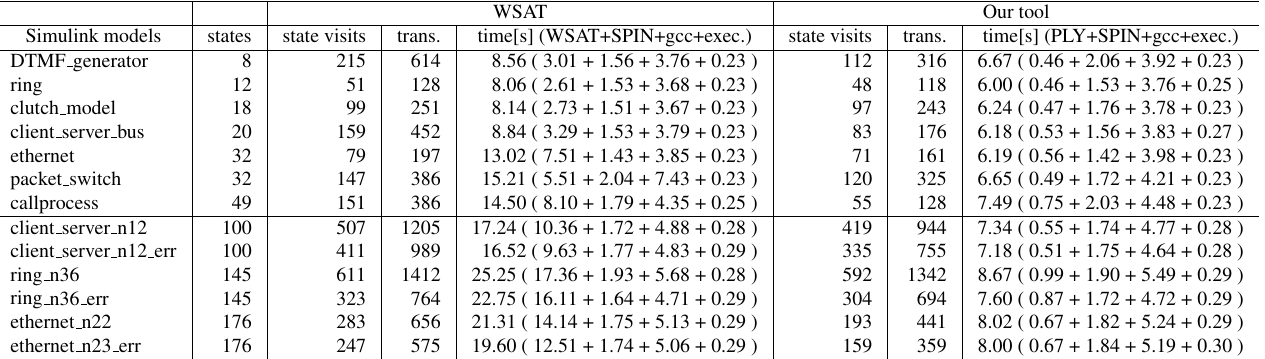
Table 3: Experimental results for checking reachability (nondeterministic) WSAT Our tool Simulink